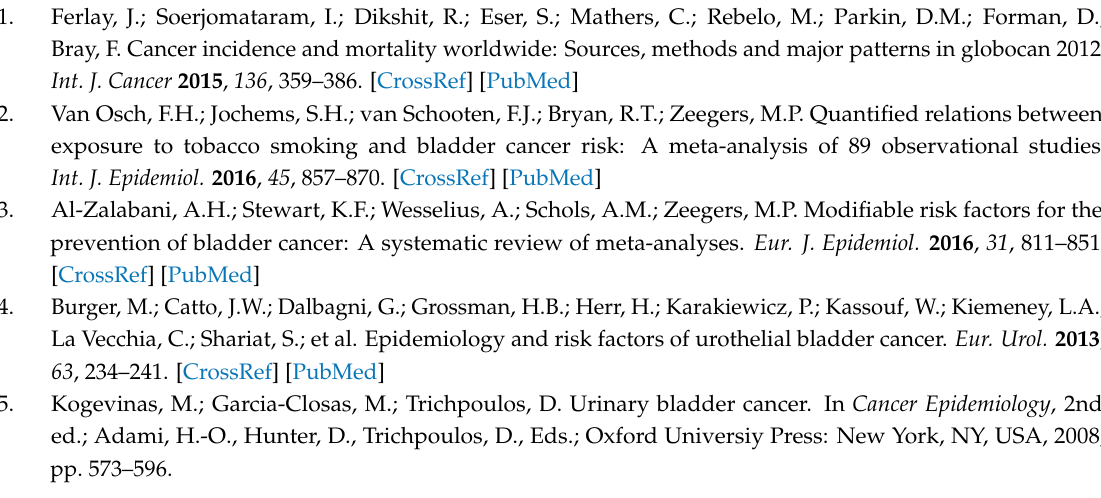
s1, Table S1: Odds ratios (OR) and 95% confidence intervals (CI) of bladder cancer according to individual components of the Mediterranean diet score (MDS). Italy,